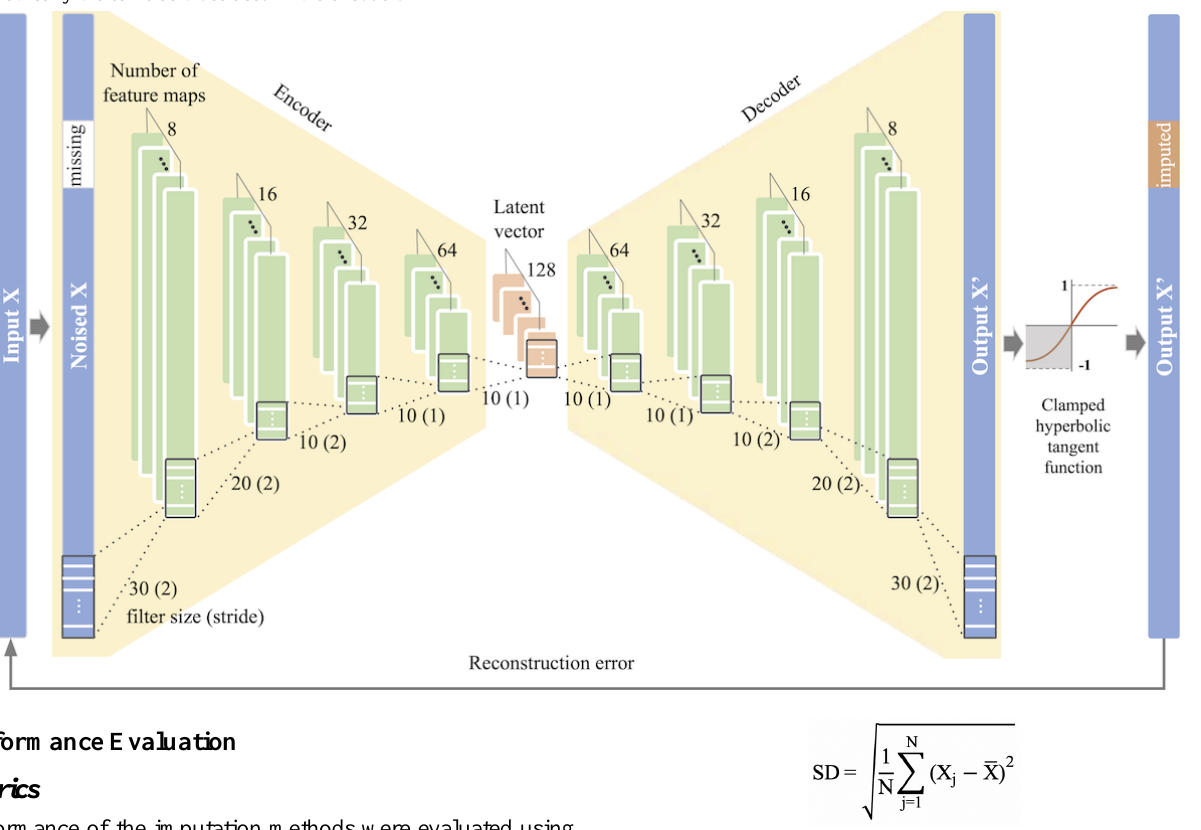
Figure 3. Model architecture for zero-inflated denoising convolutional autoencoder consisting of encoder with 5 convolutional layers in which the filter size and stride decrease and the number of feature maps increases and decoder with 5 transconvolutional layers in which hyperparameters are symmetrically the same as those used in the